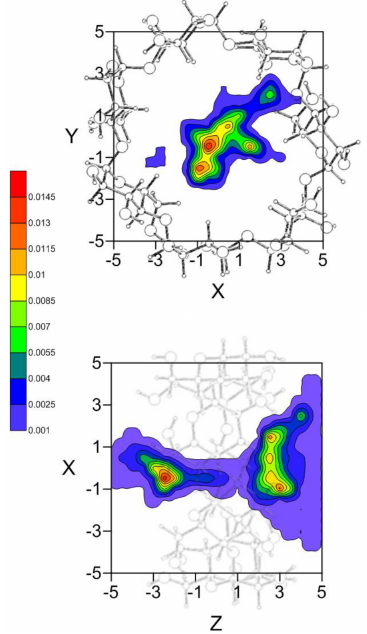
Figure 5. Projections in the XY and XZ planes of the position probability density for the inclusion of EG in β -CD. A schematic representation is included of the projections of β -CD in those planes for